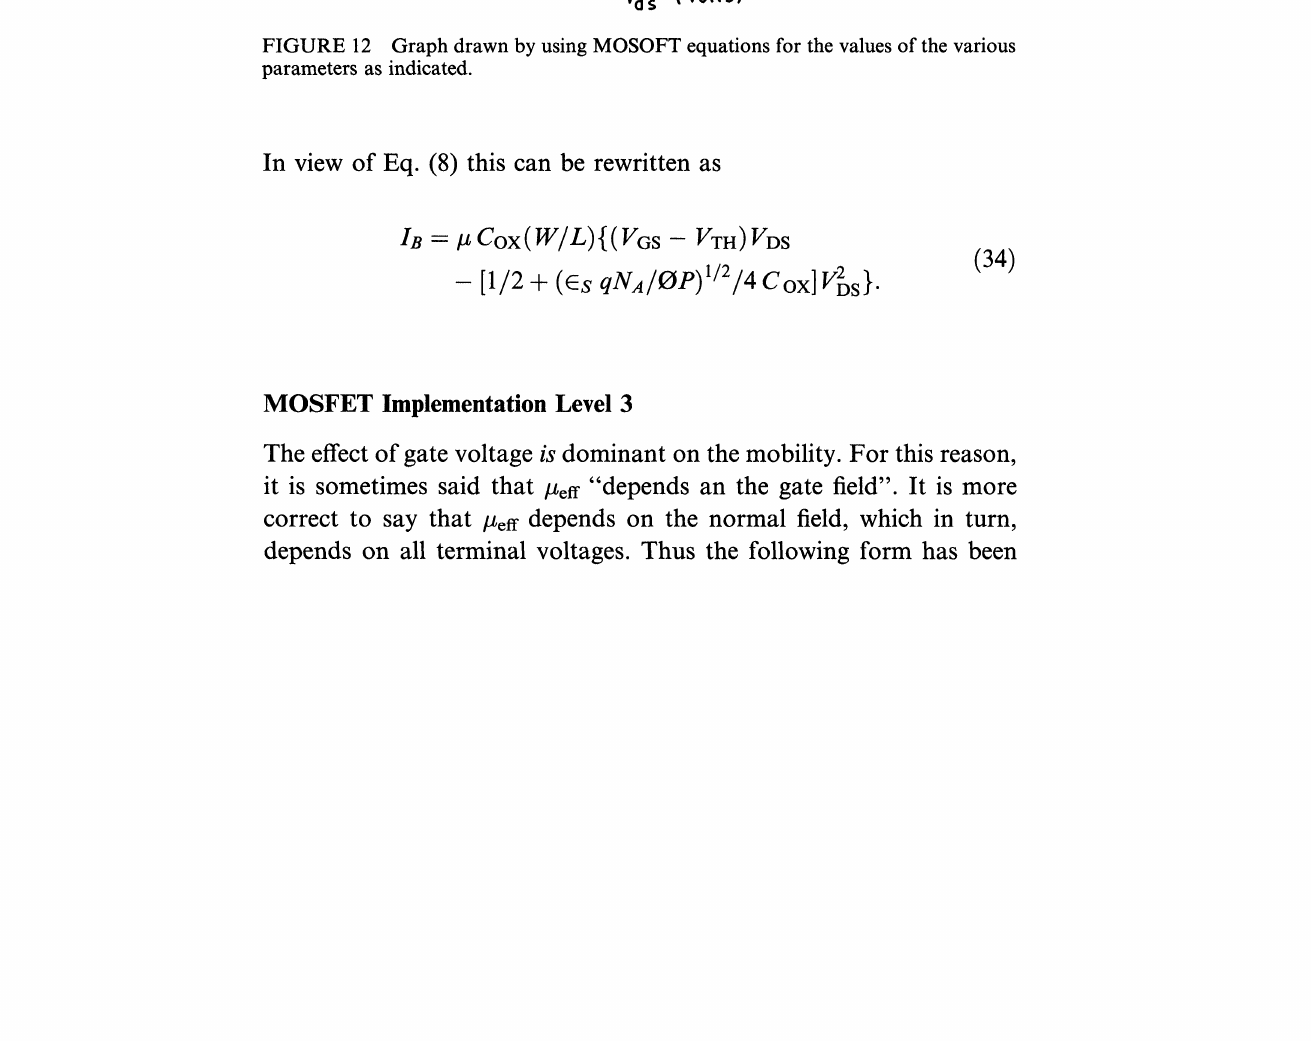
FIGURE 12 Graph drawn by using MOSOFT equations for the values of the various parameters as